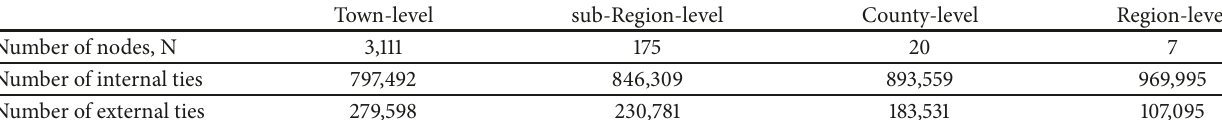
Table 1: Number of edges inside the settlement hierarchies.